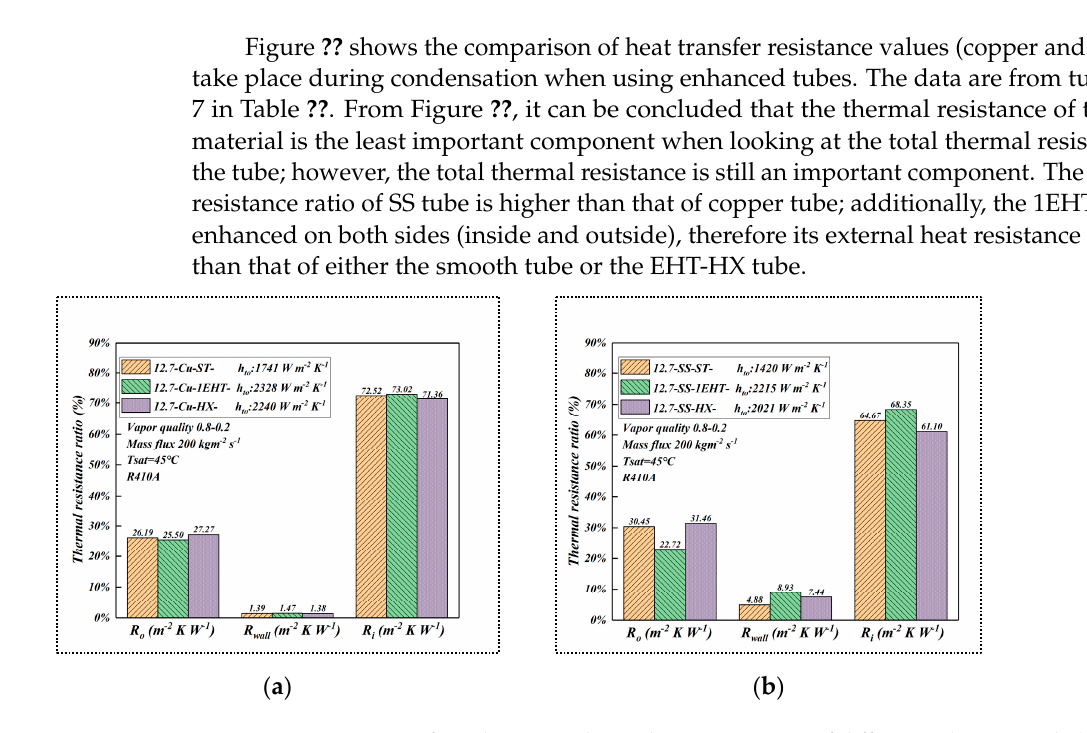
Figure 8. Comparison of HTC (as a function of mass flow rate) for tubes of the same diameter (12.7 mm) produced of different materials for smooth (ST) and enhanced (1EHT and HX) tubes.